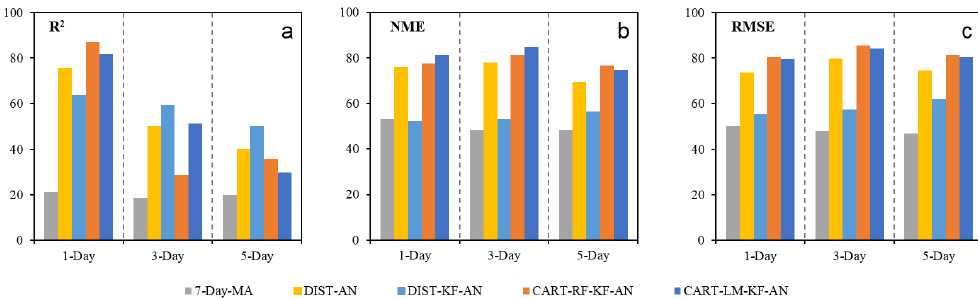
Figure 7. Percentage (%) of avg-monitors with increased R 2 values ( a ) and decreased NME ( b ) and RMSE values ( c ) by the five post-correction methods and for the 1, 3, and 5-day lead times by spatially interpolating the estimated biases.